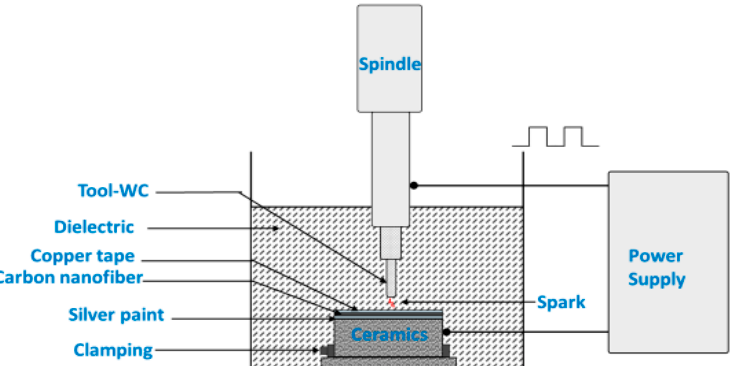
Figure 1. Schematics of experimental set-up. Table 2. Properties of Zirconia toughened Aluminum (ZTA).